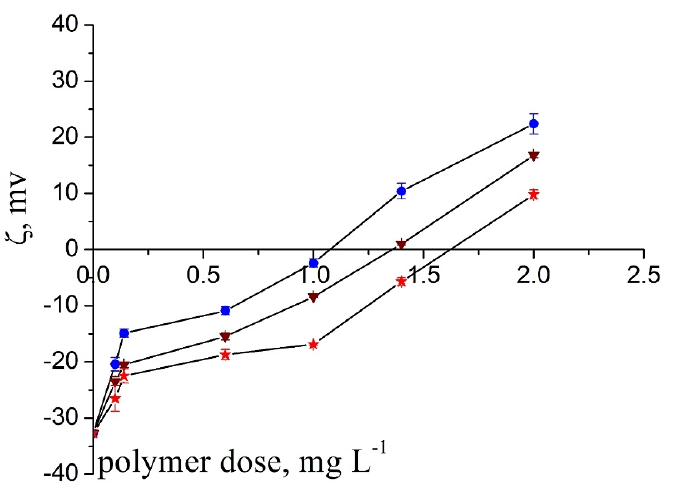
Figure 3. Zeta potential ( ζ ) dependence on the polycation dose for TMAP 0.7 –P (circle); TMAP 0.4 –P (inverted triangle); TMAP 0.2 –P (star); and settling time 120 min.